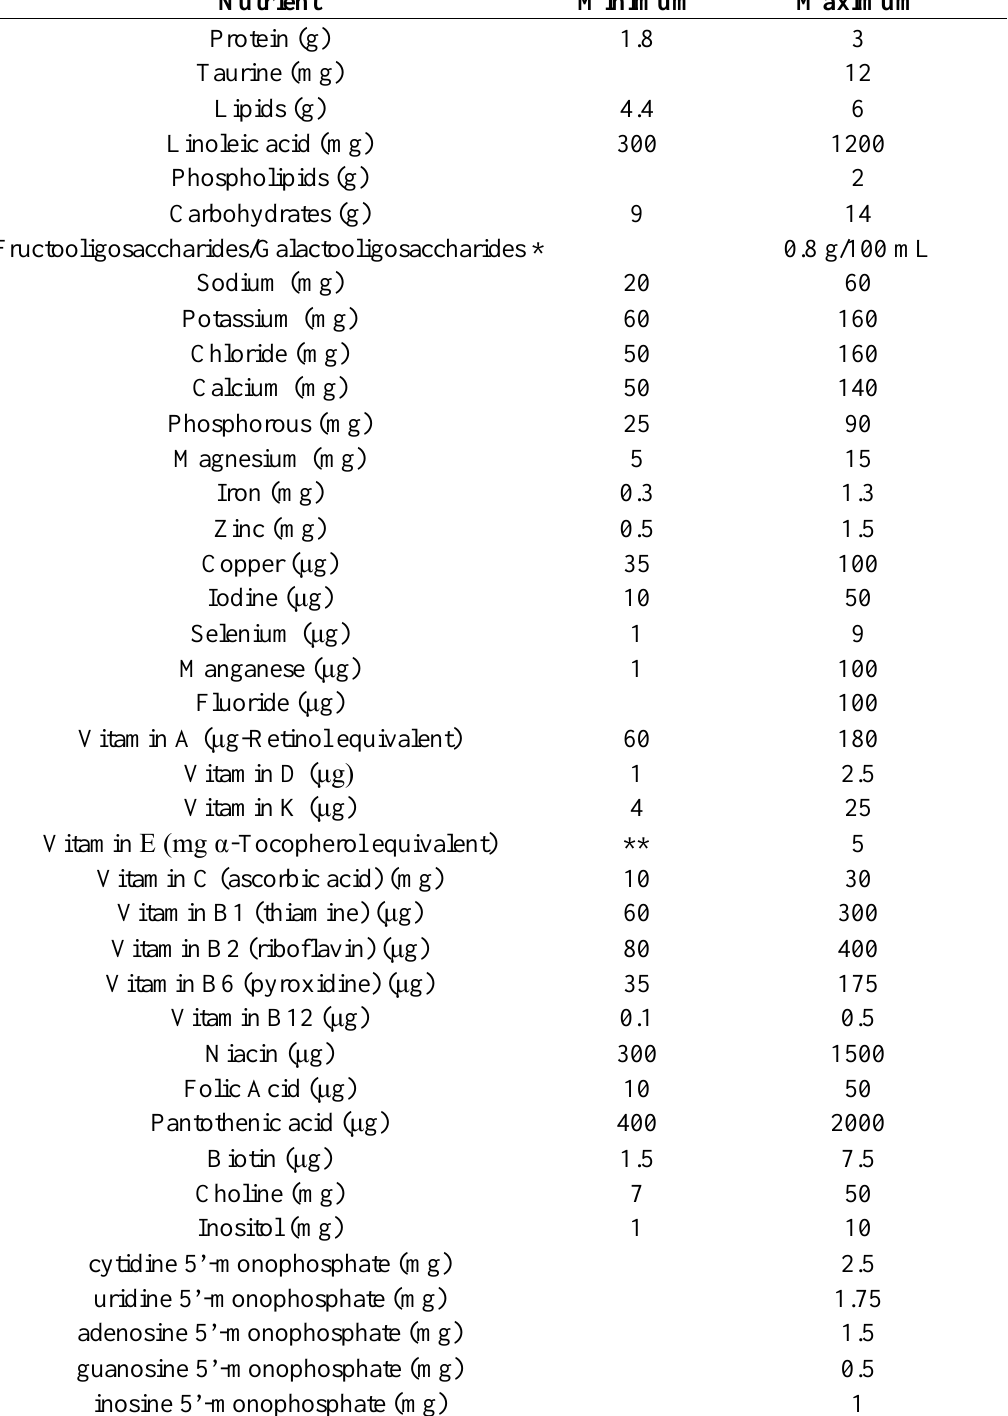
Table 1. The minimum and maximum values (/100 kcal) of the major components added to infant milk formula (adapted from